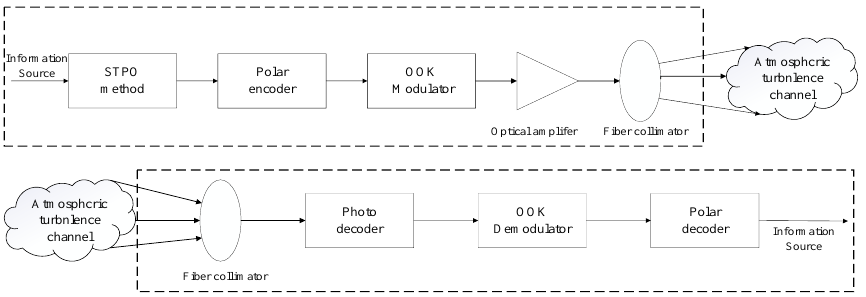
Figure 1. FSO System Model of STOP-Polar Codes.